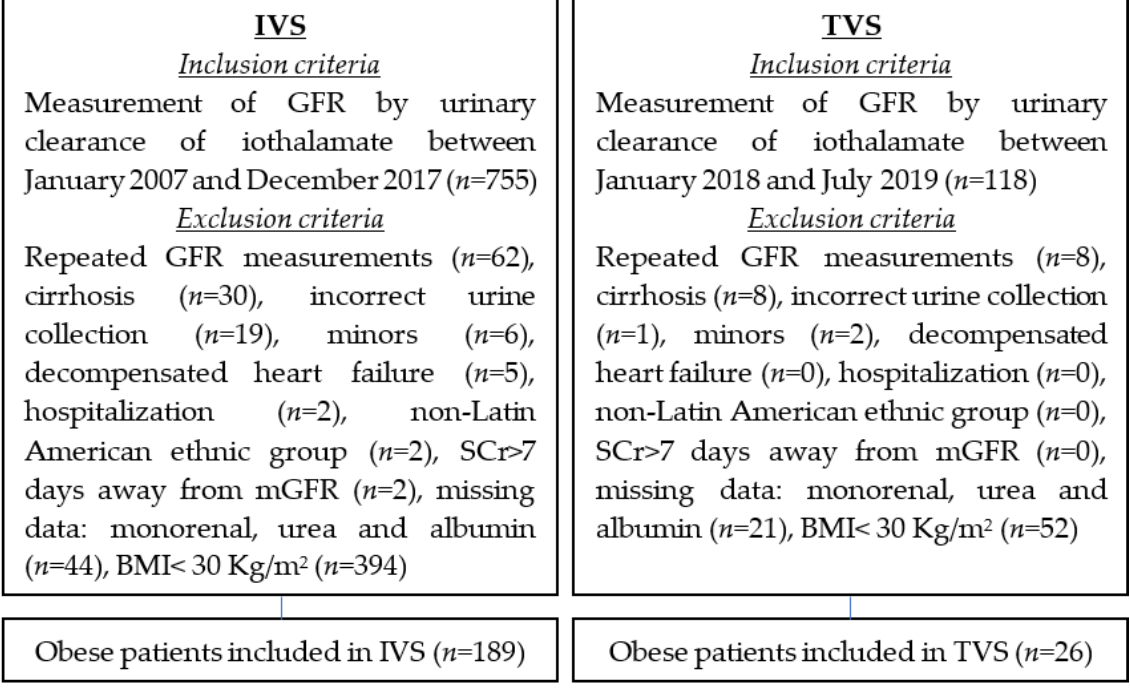
Table 1. Characteristics of all the patients, in the internal validation sample (IVS) and in the temporary validation sample (TVS).